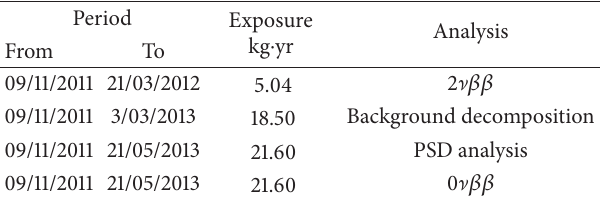
Table 1: List of the various analyses illustrated in the paper with the corresponding exposures and data taking time periods.